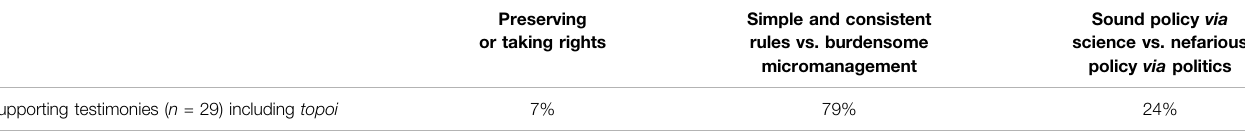
TABLE 4 | Relative Use of topoi, Supporting State